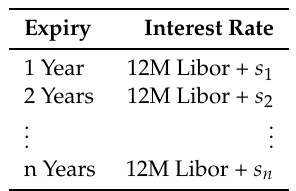
Table 1. The example term structure of funding